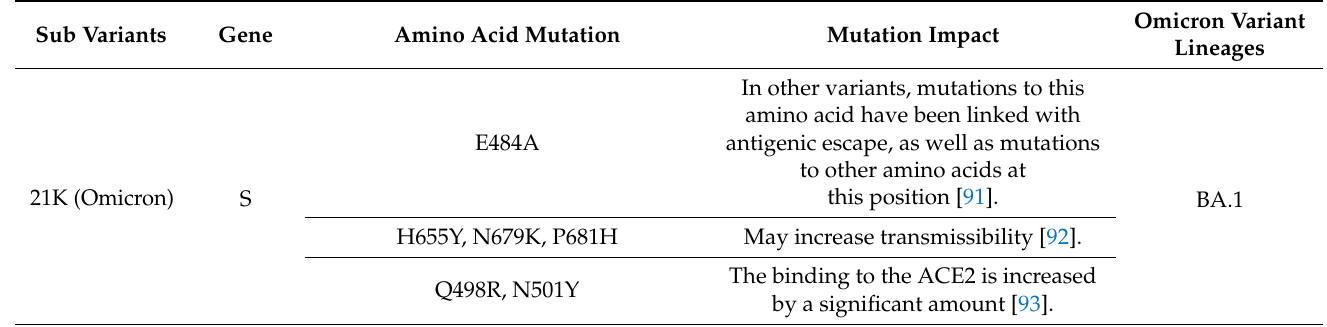
Table 2. Characteristic mutations of Omicron variants